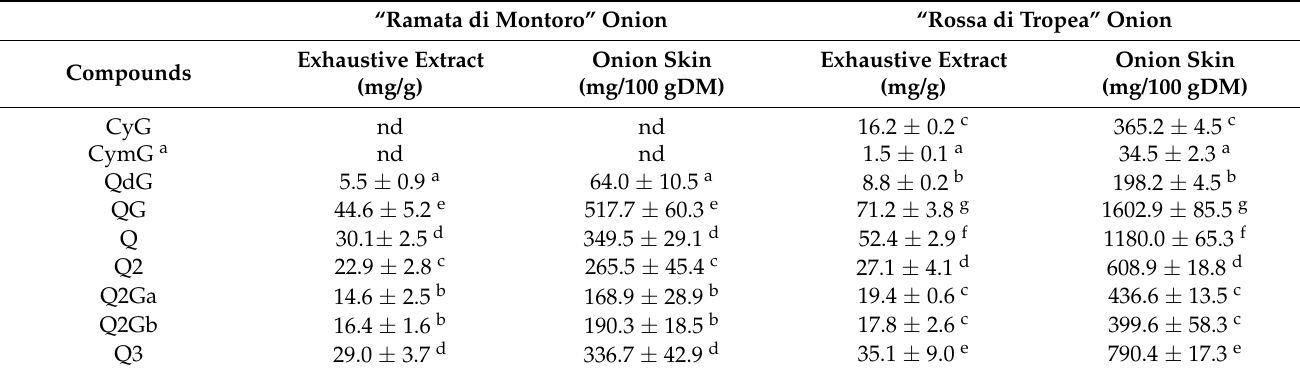
Table 2. Flavonoid content levels in “Ramata di Montoro” and “Rossa di Tropea” onion skins and their exhaustive extract. “Ramata di Montoro” Onion “Rossa di Tropea”